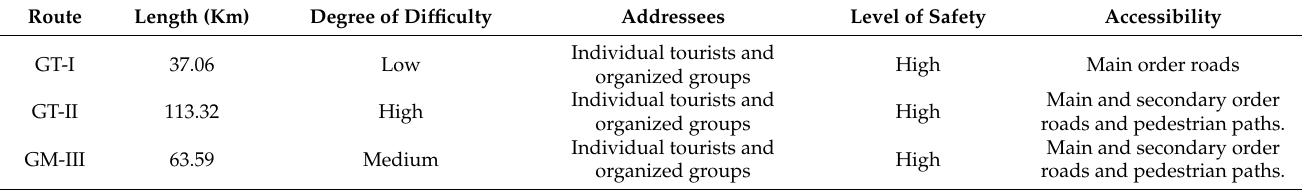
Table 3. Fundamental criteria considered for the access of its geosites and mining sites of the studied routes.